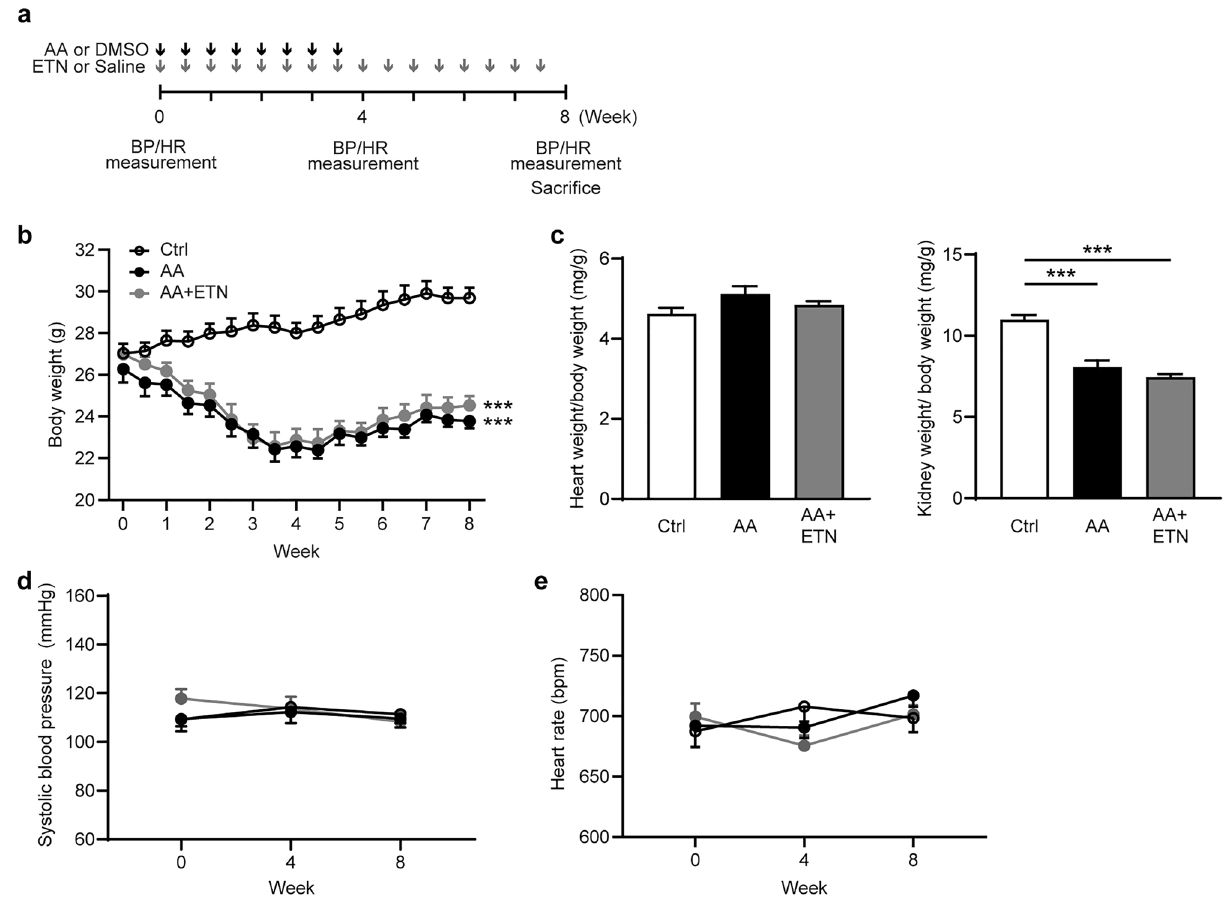
Figure 1. Effect of etanercept on body weight, tissue weight, systolic blood pressure and heart rate. ( a ) Experimental protocol. Control group received DMSO i.p. injection twice per week for 4 weeks and normal saline s.c. injection twice per week for 8 weeks. AA group received AA (3 mg/kg) i.p. injection twice per week for 4 weeks and normal saline s.c. injection twice per week for 8 weeks. AA + ETN group received AA (3 mg/ kg) i.p. injection twice per week for 4 weeks and ETN (5 mg/kg) s.c. injection twice per week for 8 weeks. Body weight was measured twice per week for 8 weeks. Blood pressure and heart rate were measured at 0, 4, and 8 weeks after the start of the experiment. ( b ) Changes in body weight. ( c ) Heart and kidney weight to body weight ratio. ( d ) Changes in systolic blood pressure. ( e ) Changes in heart rate. Values are means ± SEM, n = 8. *** P < 0.001. AA, aristolochic acid; DMSO, dimethyl sulfoxide; ETN, etanercept; BP, blood pressure; HR, heart rate; Ctrl,